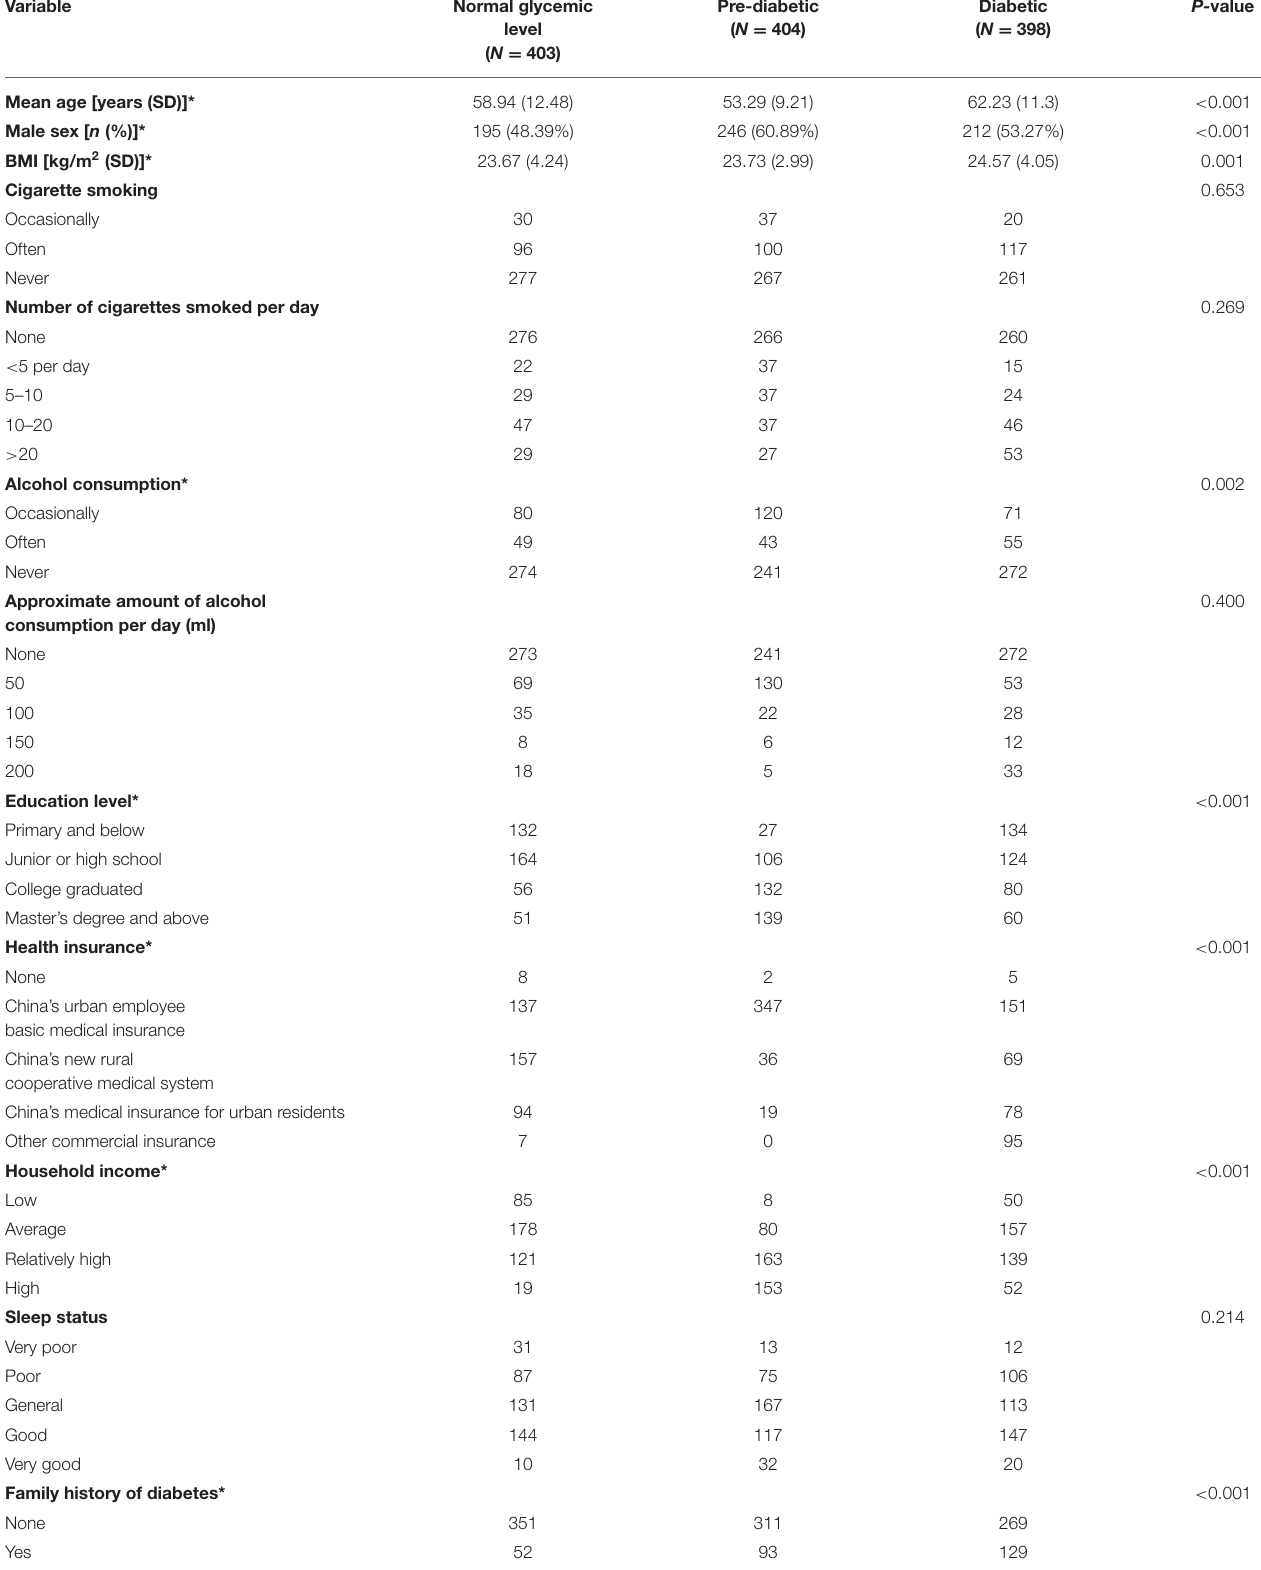
TABLE 1 | Sociodemographic features of respondents grouped by glucose status.